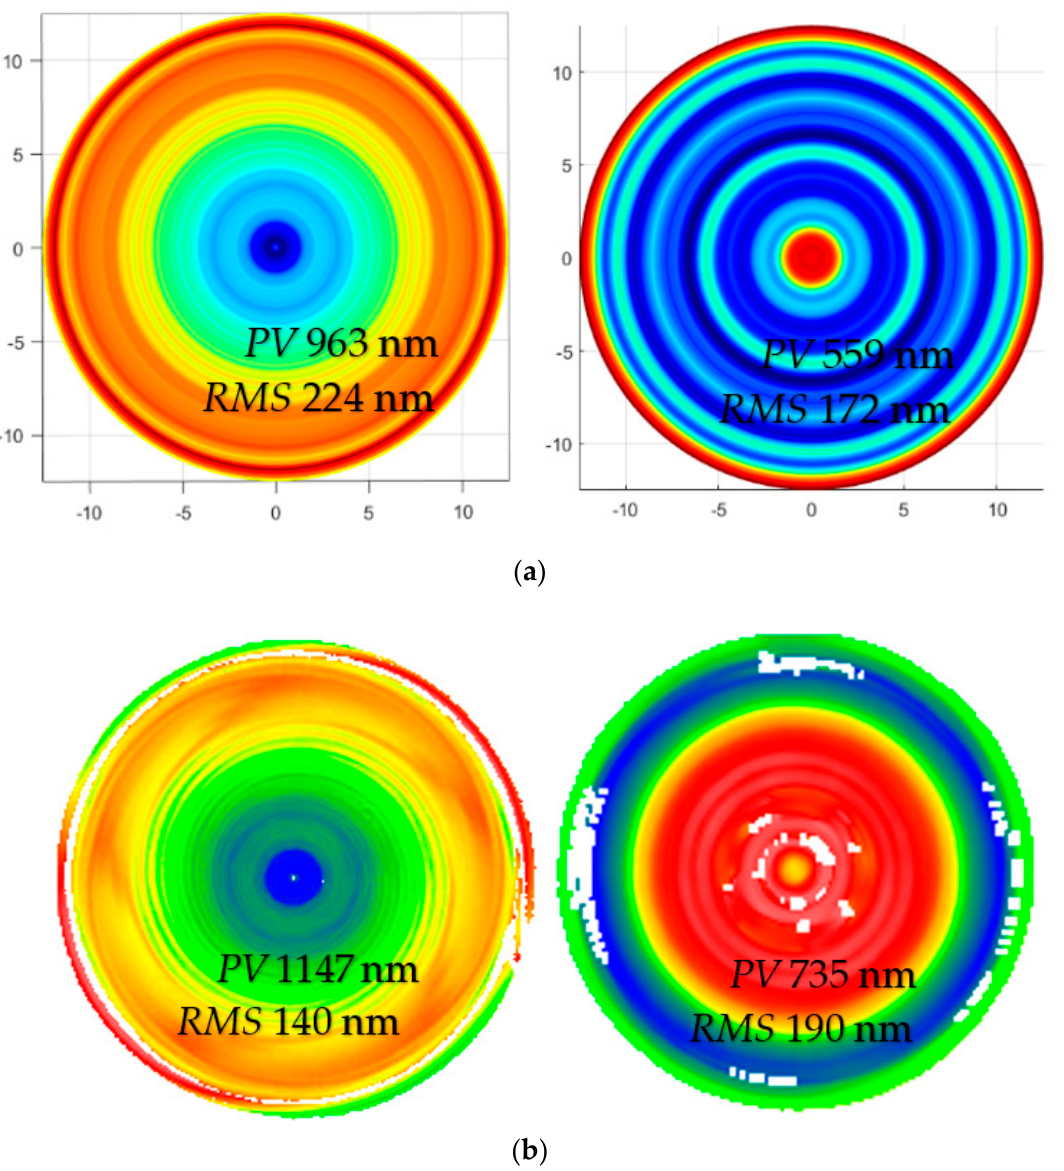
Figure 9. Surface shape simulation and actual machining results. ( a ) Simulation results. ( b ) Actual processing results.